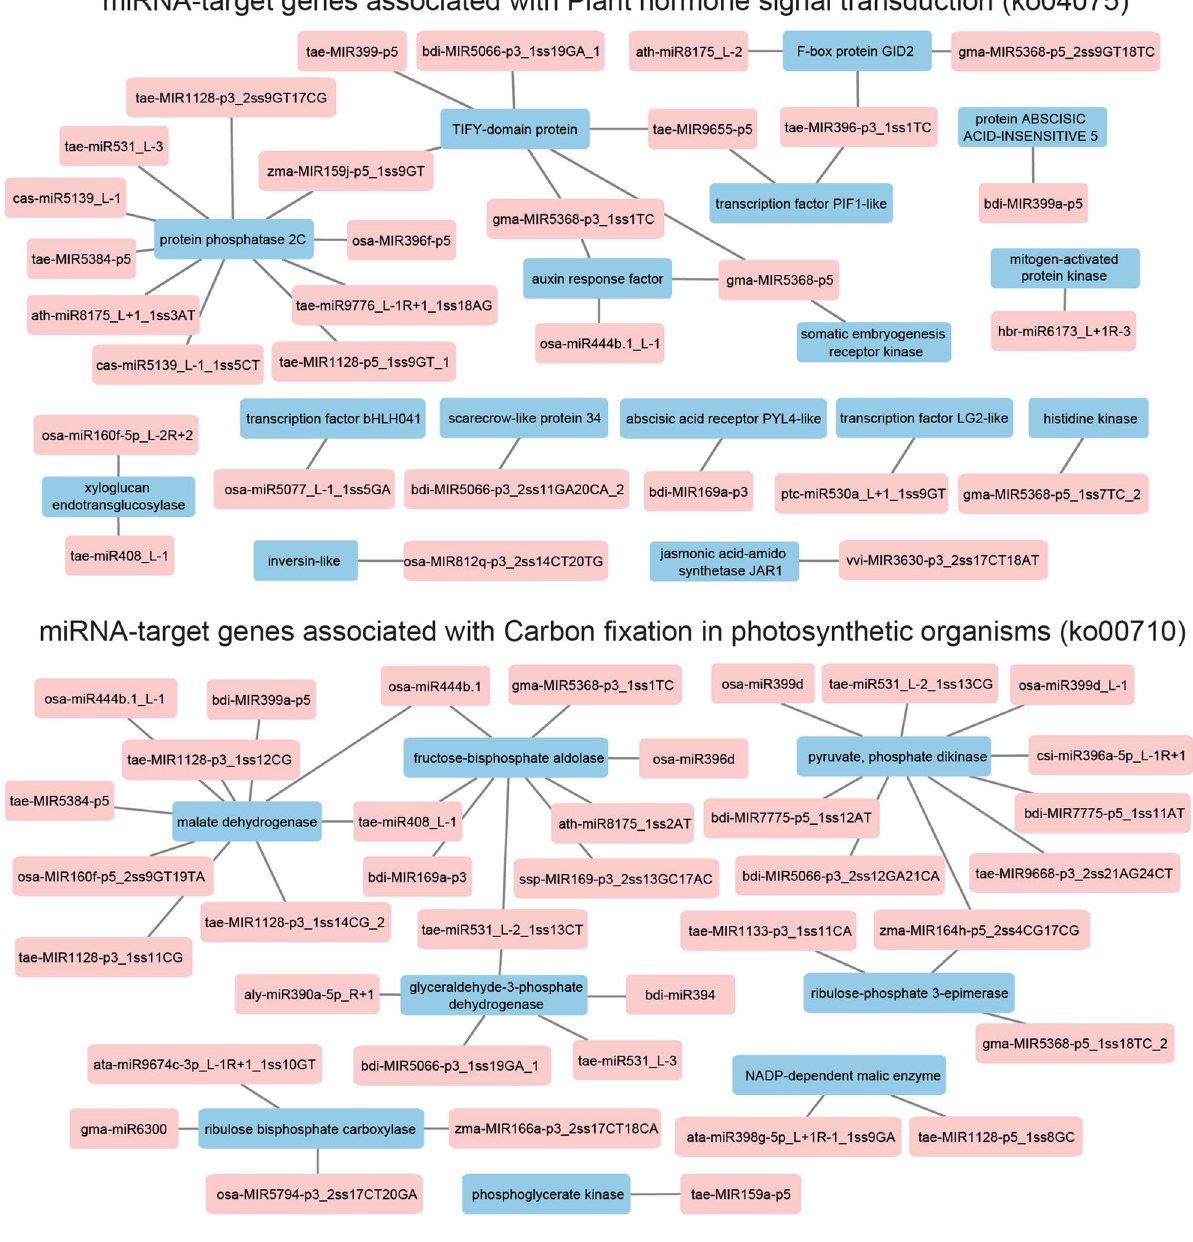
Figure 6. Significant miRNA-modules with antagonistic regulatory patterns, during transgenerational water stress, that are involved in KEGG (https ://www.kegg.jp/kegg/kegg1 .html) pathways ko04075—Plant hormone signal transduction and ko00710—Carbon fixation in photosynthetic organisms, respectively. miRNAs are shown in pink, mRNA targets are shown in blue. F-box protein GID2, an F-box subunit of the SCF E3 complex. TIFY-domain protein, protein with conserved amino acid pattern